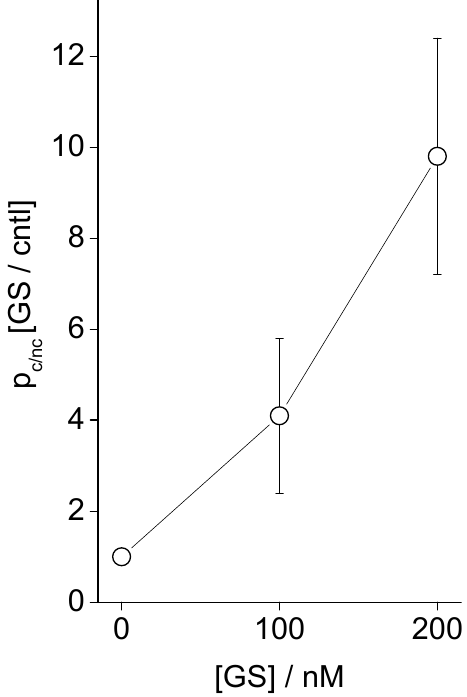
Figure 5. Effects of GS on CD-induced channel opening probability p c/nc (Equation (1)). Along the y-axis is plotted the membrane conductance probability relative to the membrane nonconductance probability, being normalized by the value without the effects of GS (control condition).